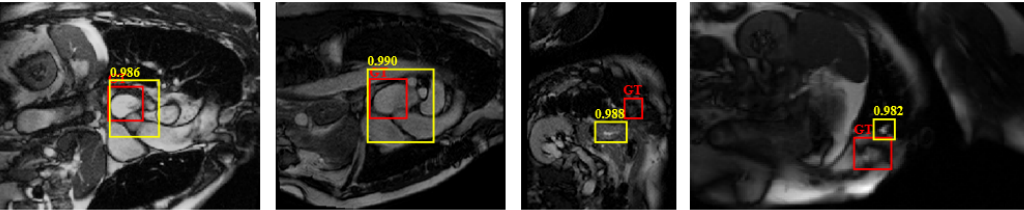
Figure 11. Examples of failure detection results by our method, where red rectangles denote ground-truth and yellow ones denote our